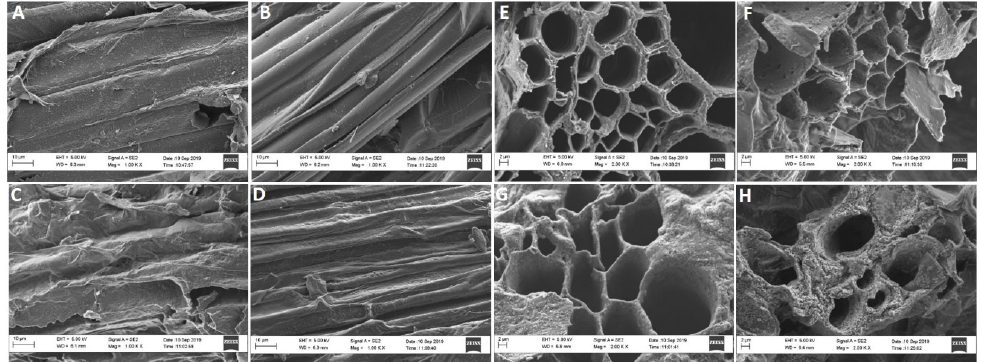
Figure 5. Anatomical image showing the epidermis and xylem layers of Sorghum bicolor analyzed using Scanning Electron Microscopy. Cross section of epidermis layer of seedlings under ( A ) 0 mM NaCl, ( B ) 0 mM NaCl + 5 mM Ca 2+ , ( C ) 300 mM NaCl, ( D ) 300 mM + 5 mM Ca 2+ . Cross section of the xylem layers of seedlings under ( E ) 0 mM NaCl, ( F ) 0 mM NaCl + 5 mM Ca 2+ , ( G ) 300 mM NaCl, ( H ) 300 mM + 5 mM Ca 2+ .